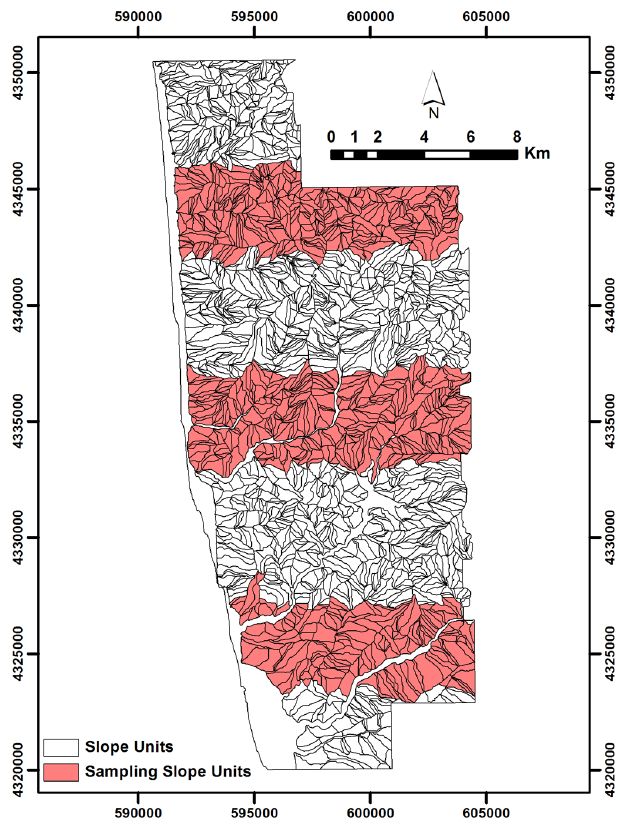
Fig. 8. Slope unit and sampling slope unit map of study